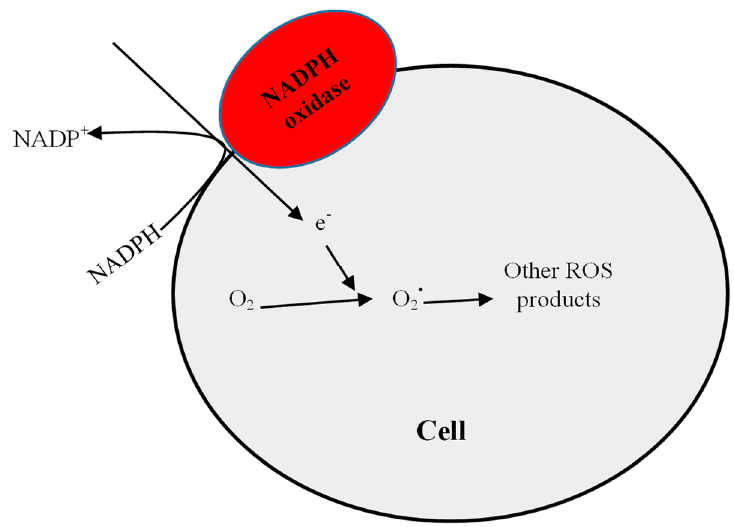
Figure 2. Schematic representation of NADPH oxidase-dependant ROS generation. NADPH under the influence of the plasma membrane-bound NADPH oxidase donates an electron, which is accepted by molecular oxygen to form the superoxide (O 2 • ) radical.